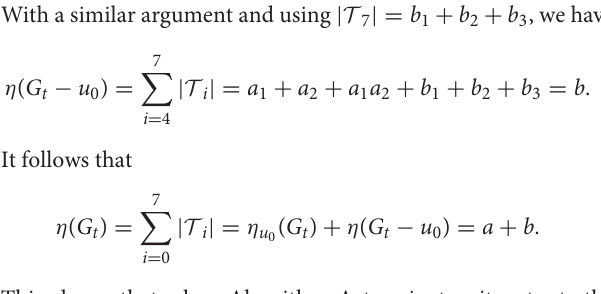
(iii) The value of a + b, denoted by η ( G t ) , is the number of subtrees in G t